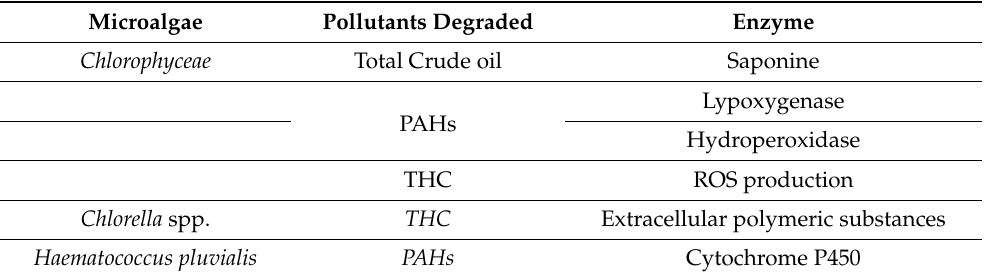
Table 2. Principal enzymes and molecules involved in bioremediation process.